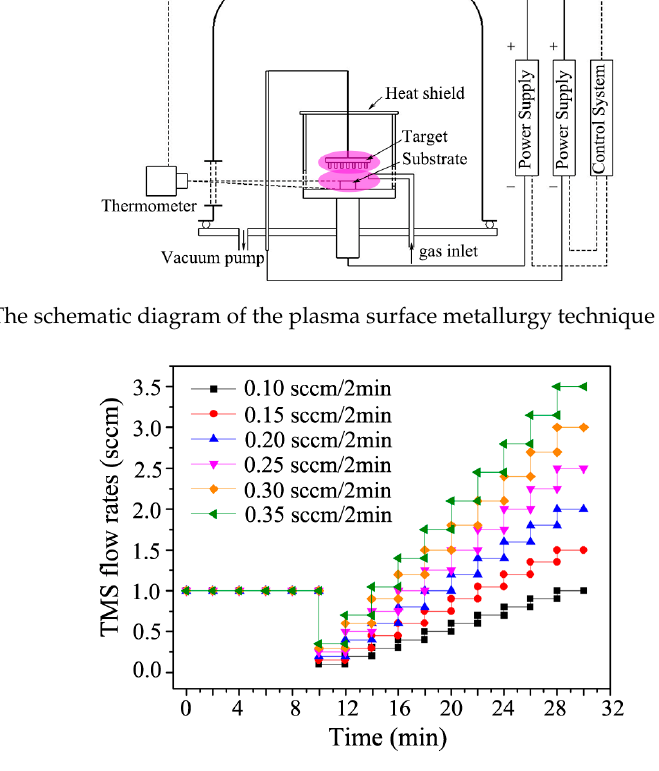
Figure 2. TMS (tetramethylsiline) flow rates during the second and third steps in the PSMT treatment as a function of